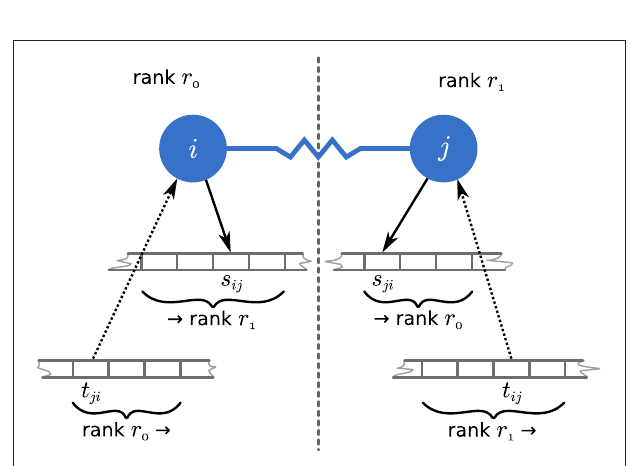
FIGURE 3 | Access to MPI buffers for communication of continuous-data events. Neuron i on MPI rank r 0 and neuron j on MPI rank r 1 (blue filled circles) are coupled through a gap junction (blue line), which requires them to exchange continuous-data events in every communication step. To this end, each neuron always writes to the same send-buffer position s ij and s ji , respectively (black solid arrows) and reads from the corresponding receive-buffer positions t ji and t ij , respectively (black dotted